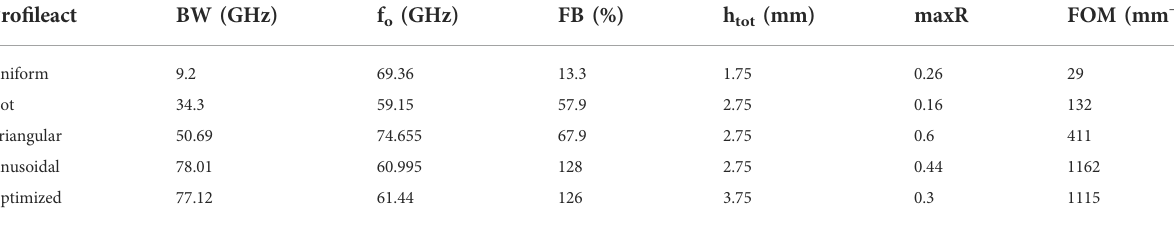
TABLE 4 Bandwidth and FOM performances for the various investigated pro fi